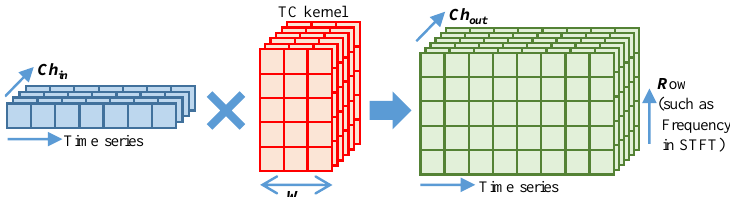
Figure 3. Transposing convolution 1D to